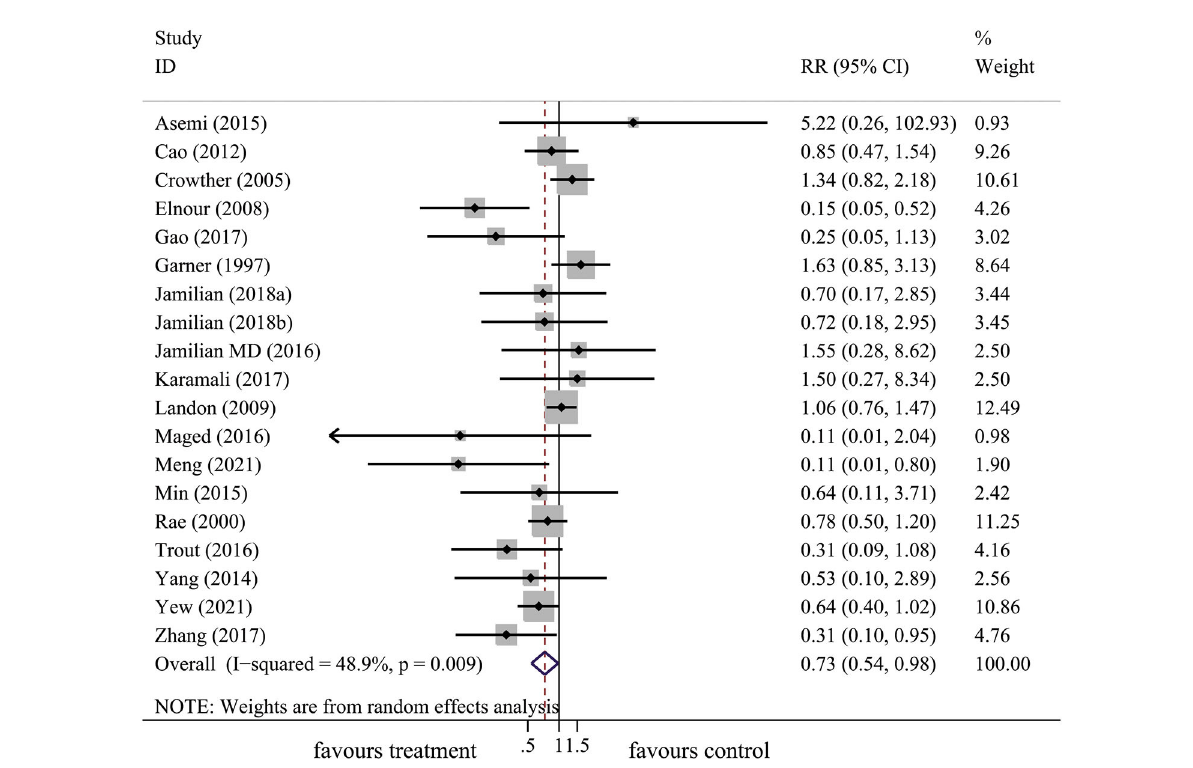
FIGURE4 The forest plot demonstrated the effect of prenatal lifestyle intervention in women with GDM on the risk of neonatal hypoglycemia by pooling data from 18 studies.